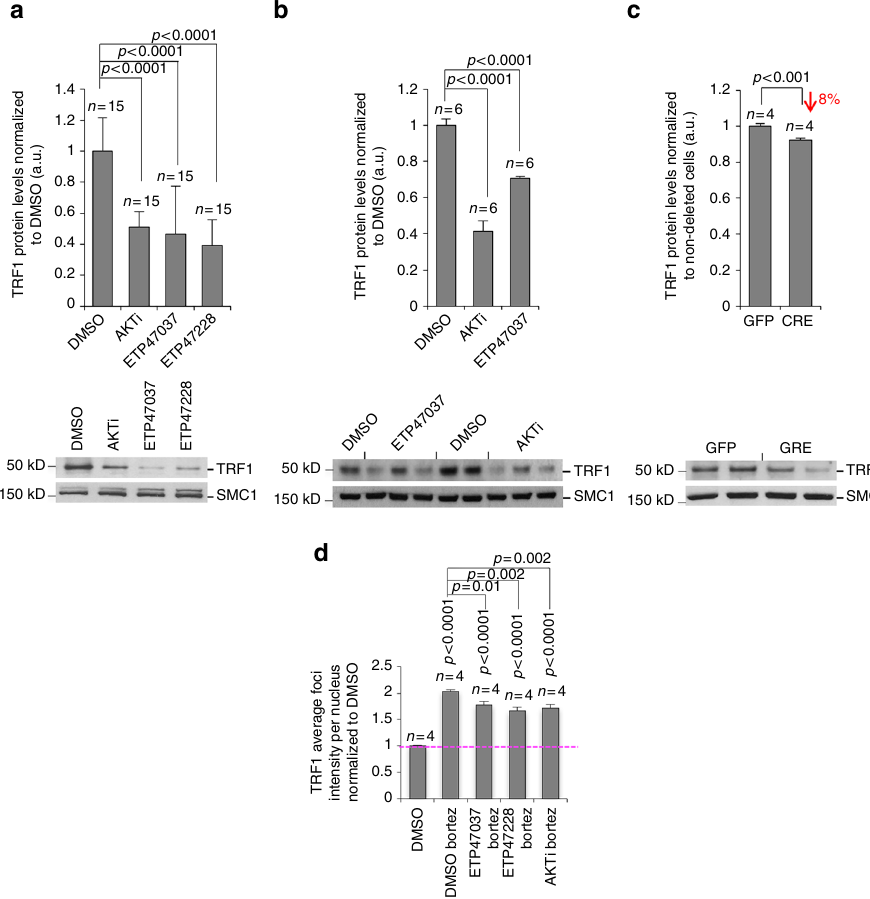
Fig. 4 PI3K/AKT inhibitor post-translationally downregulate TRF1 levels. a Quanti fi cation of total nuclear TRF1 levels in lung cancer-derived cells (CHA